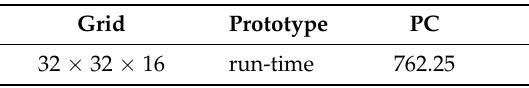
Table 2. Rendering time (s).